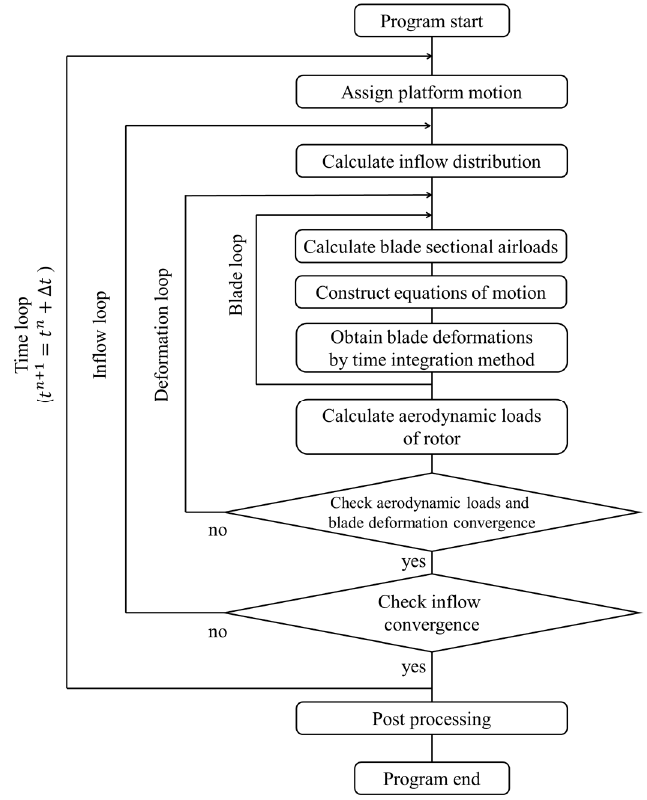
Figure 2. Flow diagram of aeroelastic analysis for floating offshore wind turbine rotor blades.